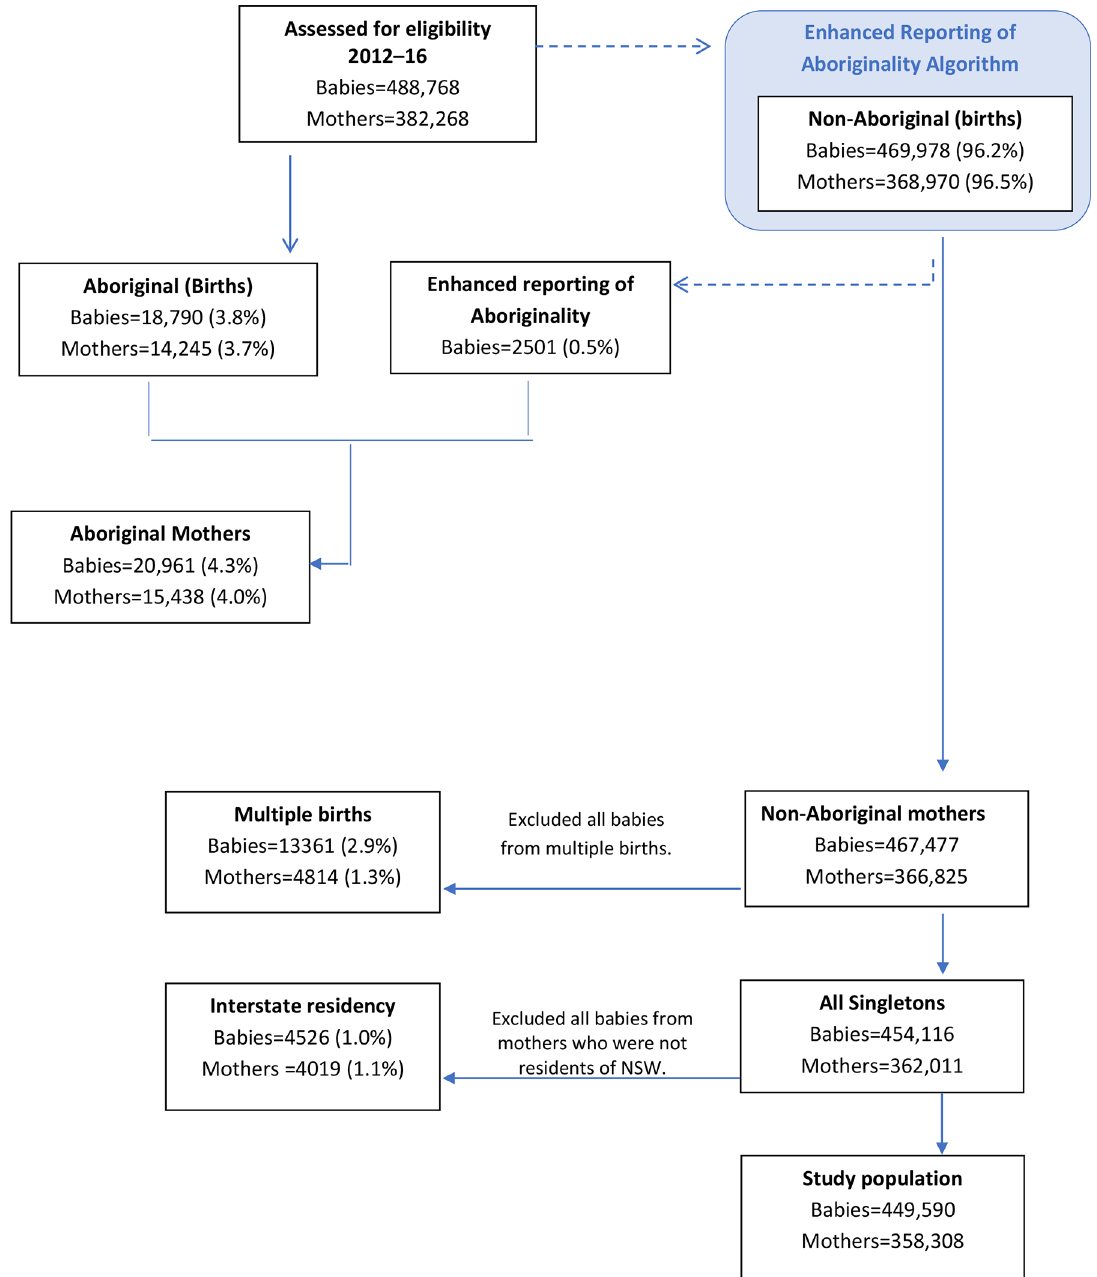
Figure 1: Flow diagram of mothers and babies eligible for inclusion in the final study